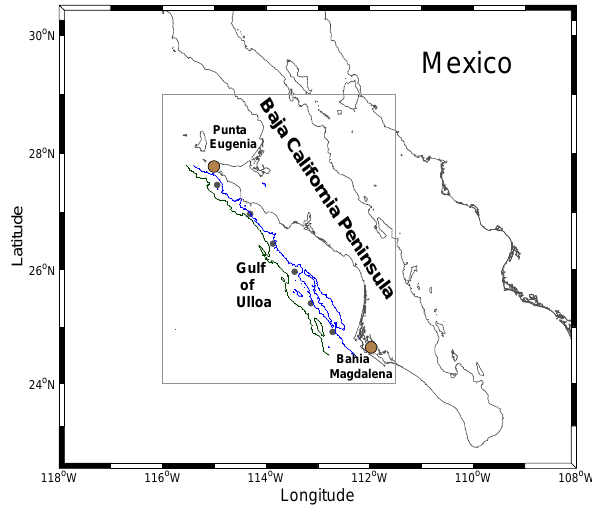
Fig. 1. The Gulf of Ulloa. The thin blue and green lines indicate the isobaths of 200m and 1500m, respectively. The six grey filled circles on the limit on the continental shelf are the sample sites of the net primary productivity, currents and winds to generate mean time series for the region. The brown circles are the positions of Punta Eugenia and Bah´ıa Magdalena, respectively. The rectangle shows the region that will be used in Figs. 2 to